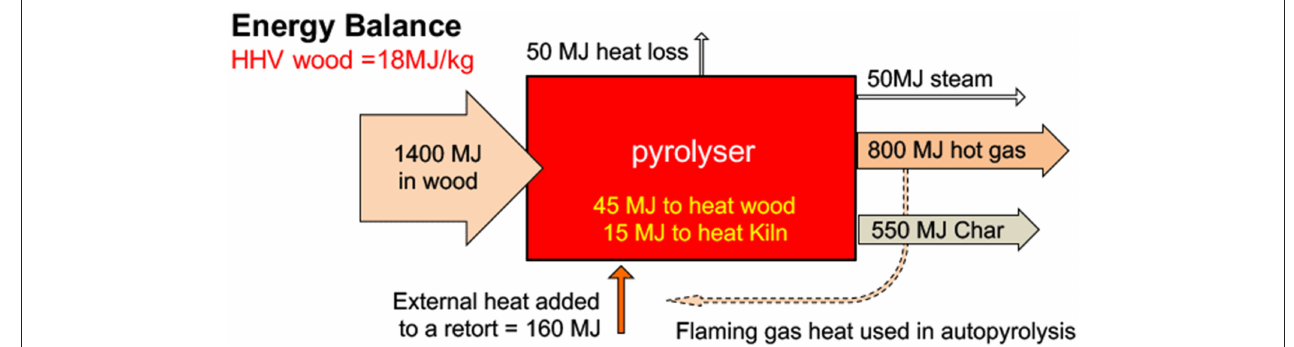
FIGURE 1 | Energy balance for biochar production from wood biomass. HHV is the higher heating value, a measure of energy content, including the latent heat of vaporization of water in the biomass (adapted from Joseph et al.,